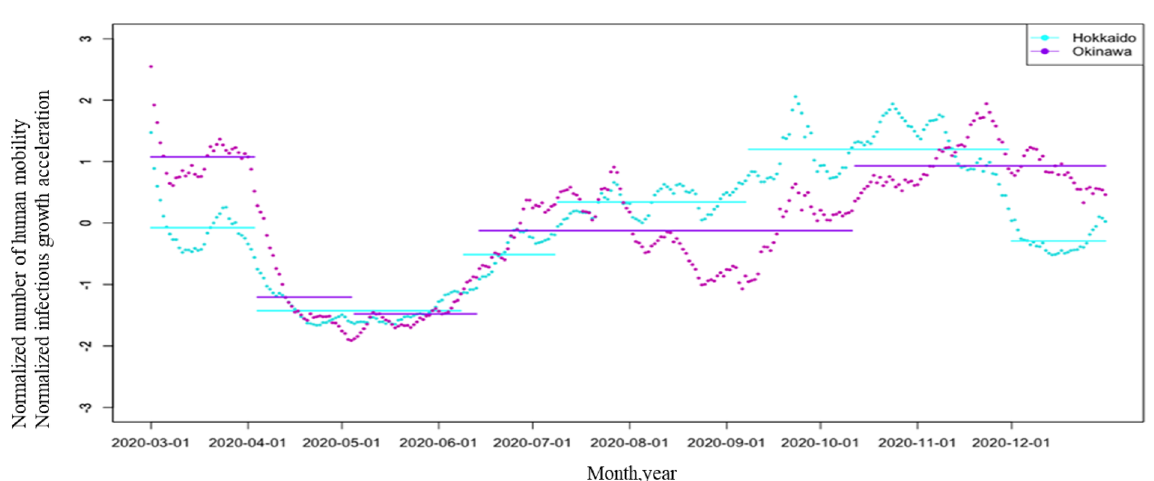
Figure 3. Plot of inter-human-mobility 2020/3/1 ~ 2020/12/12 in Hokkaido and Okinawa, and means of each period given by change point detection. LocationMind xPop © LocationMind